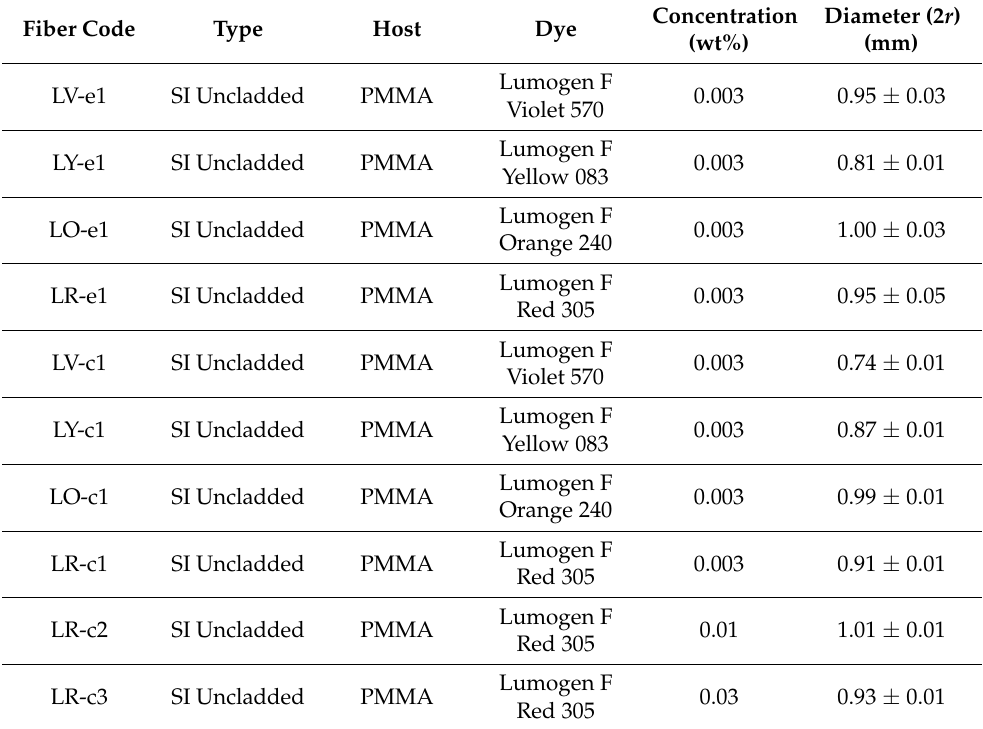
Table 1. Properties of the fiber samples doped with lumogen dyes. e: extrusion method and c: casting method used to produce doped preforms. The fibers are step-index fibers and they have no cladding. r is the fiber